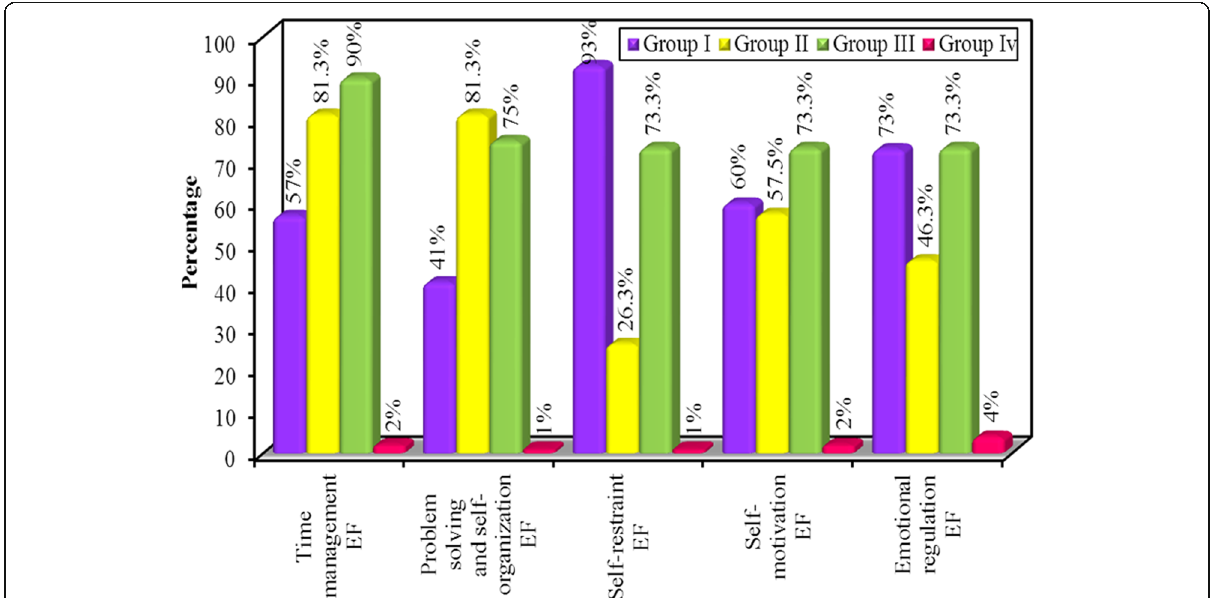
Fig. 3 Comparison between the different studied groups according to executive